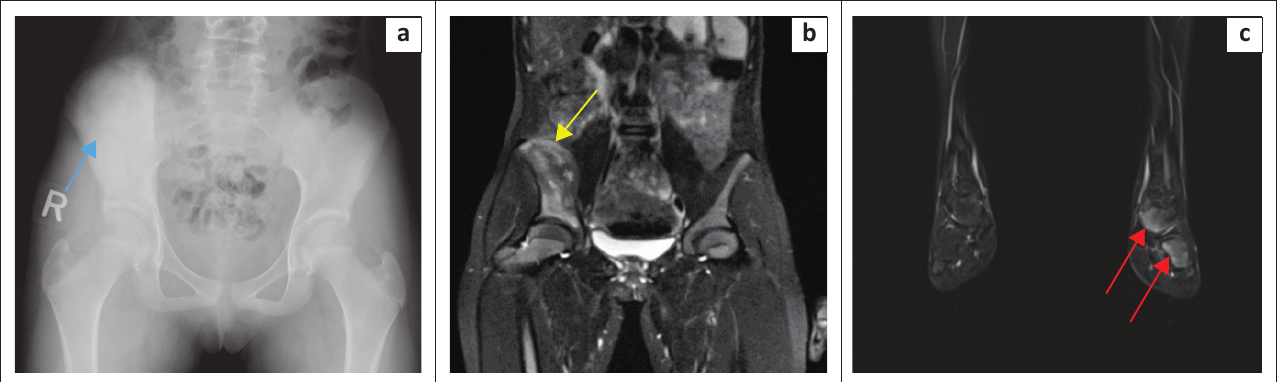
FIGURE 3: Follow-up imaging with a radiograph of the pelvis and whole-body magnetic resonance imaging (MRI) performed 3 months after treatment: (a) Plain radiograph of the pelvis showing similar findings of sclerosis of right iliac wing. (b) Magnified fat-saturated T2 weighted coronal image on whole-body MRI shows significant improvement of the oedema and surrounding periosteal reaction (arrow). Note the absence of adjacent muscle inflammation. (c) Magnified section of the whole-body MRI, coronal T2 weighted fat-saturated MR image of the left lower leg showing increased marrow signal involving the inferior talus, cuboid (arrows) and base of 5th metatarsal bone (not shown). This involvement of multiple bones with regression of inflammation in the ilium after conservative treatment confirms the diagnosis of chronic recurrent multifocal